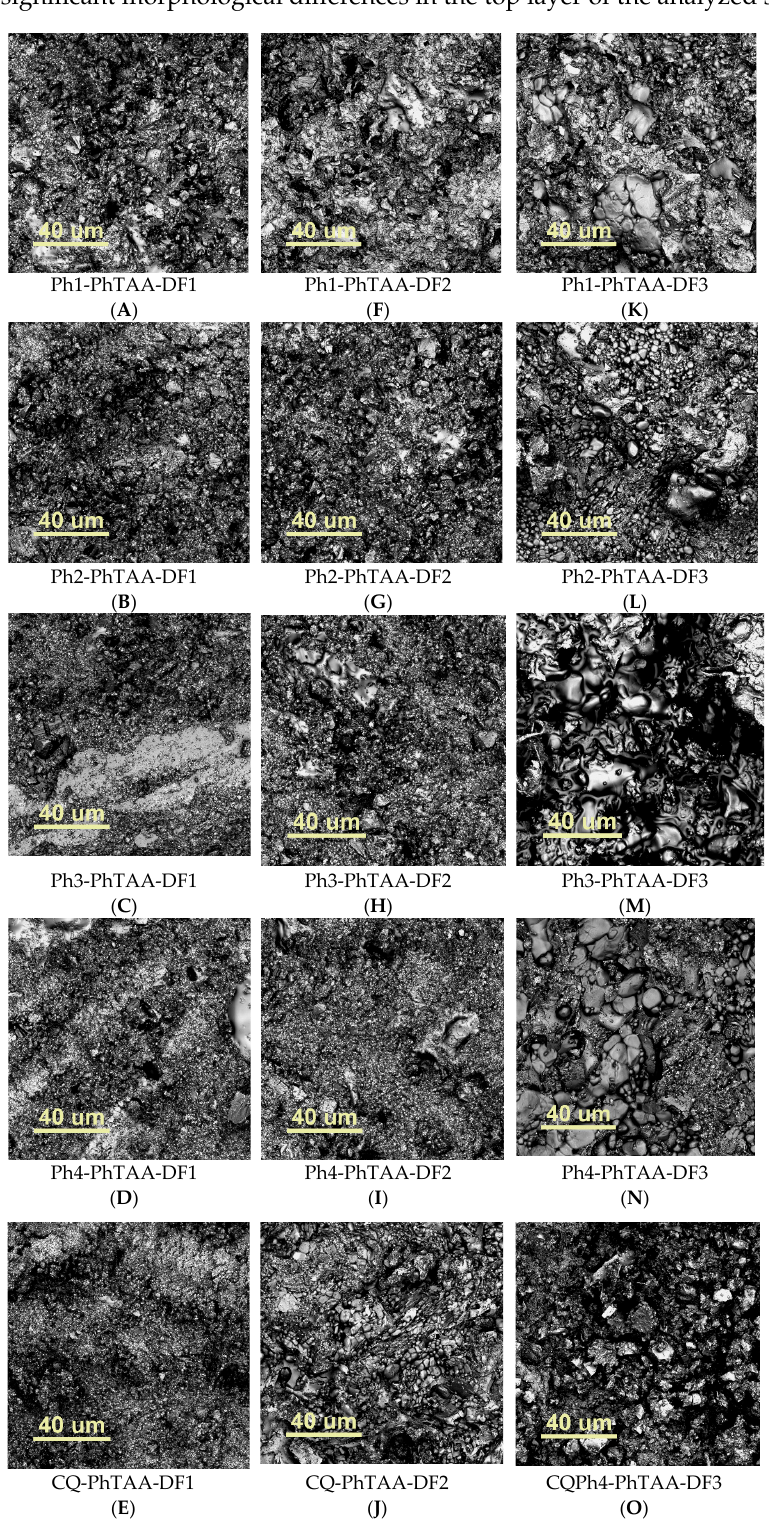
Figure 6. Images taken with a confocal optical microscope (COM); abbrev.: dibenzo[a,c]phenazine (Ph1), benzo[a]phenazine (Ph2), 11 H -indeno[1,2-b]quinoxalin-11-one (Ph3), 6 H -indolo[2,3-b]quinoxaline (Ph4), (phenylthio)acetic acid (PhTAA), DF1—filler Ketac Fil Plus, DF2—Kromoglass 2 and DF3—i-FIX LC Light Curing Glass Ionomer Filling Cement.